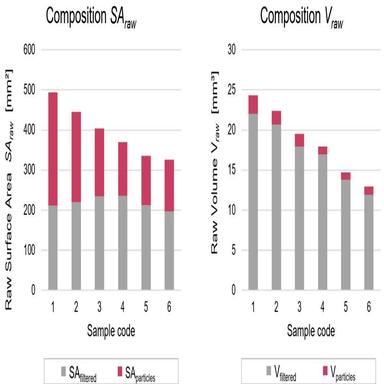
Composition of the surface area (left) and volume (right) of the raw structures.